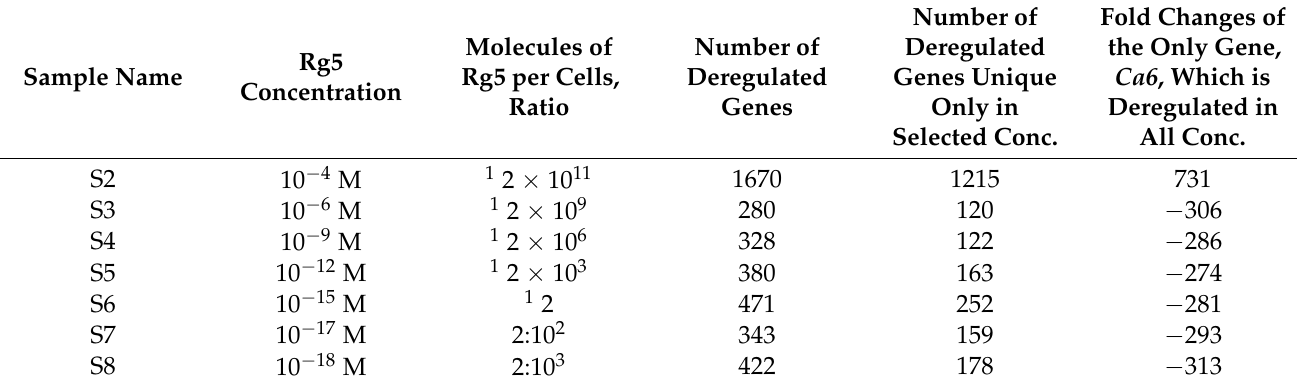
Table 1. Number of genes deregulated 1 by ginsenoside Rg5 in different concentrations in the murine hippocampal neuronal cell line HT22. For details, see Supplemental Table S3 in Supplement 2.